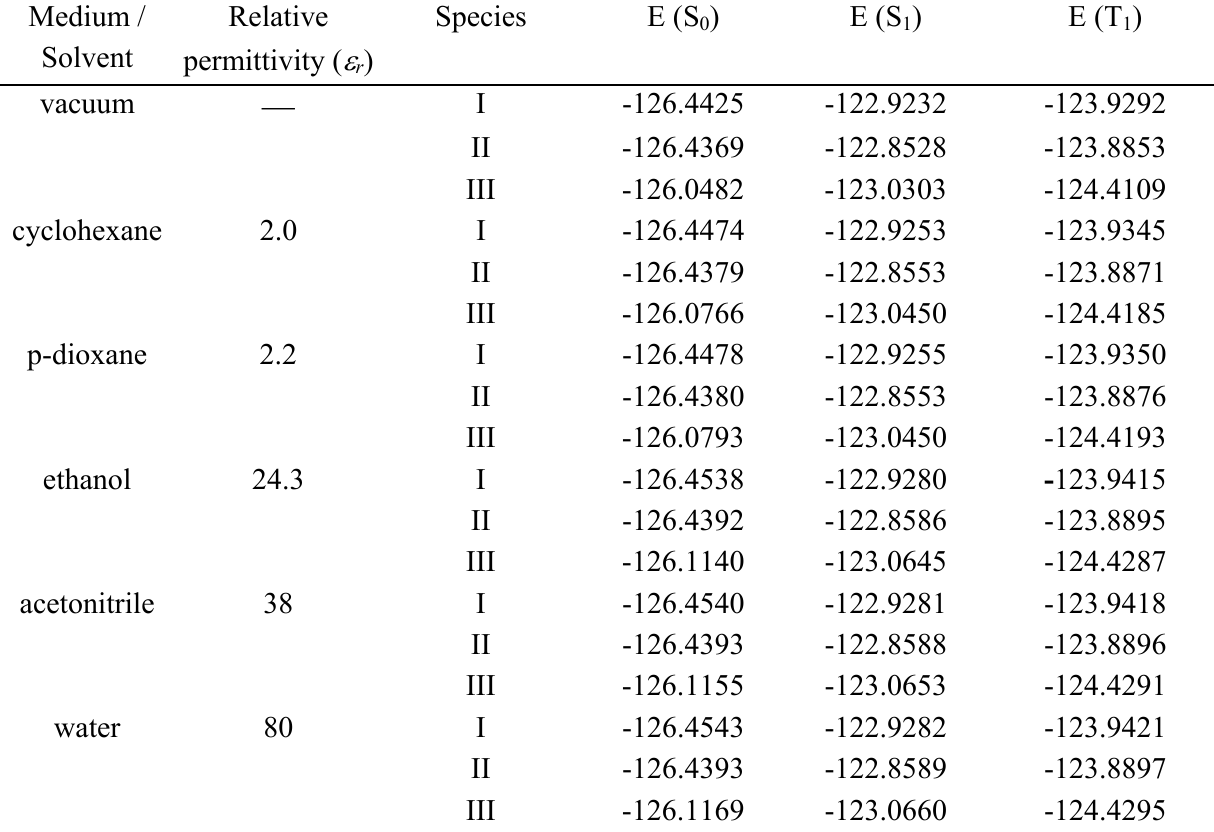
Table 3. Calculated S , S and T energies (eV) of the normal (I), rotamer (II) and tautomer (III) of 0 1 1 HBO in isolated and solvated conditions (Onsager’s cavity radius, a = 5.46